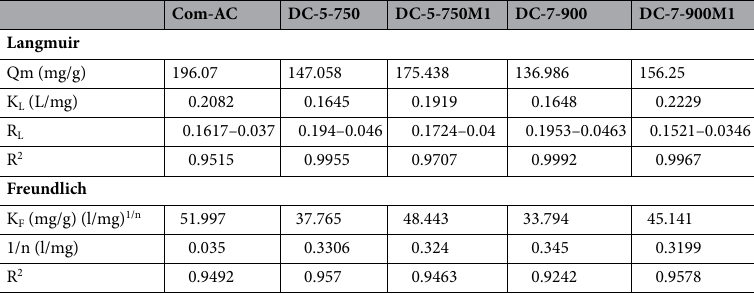
Table 9. Parameters value of Langmuir and Freundlich isotherm of MR removal.